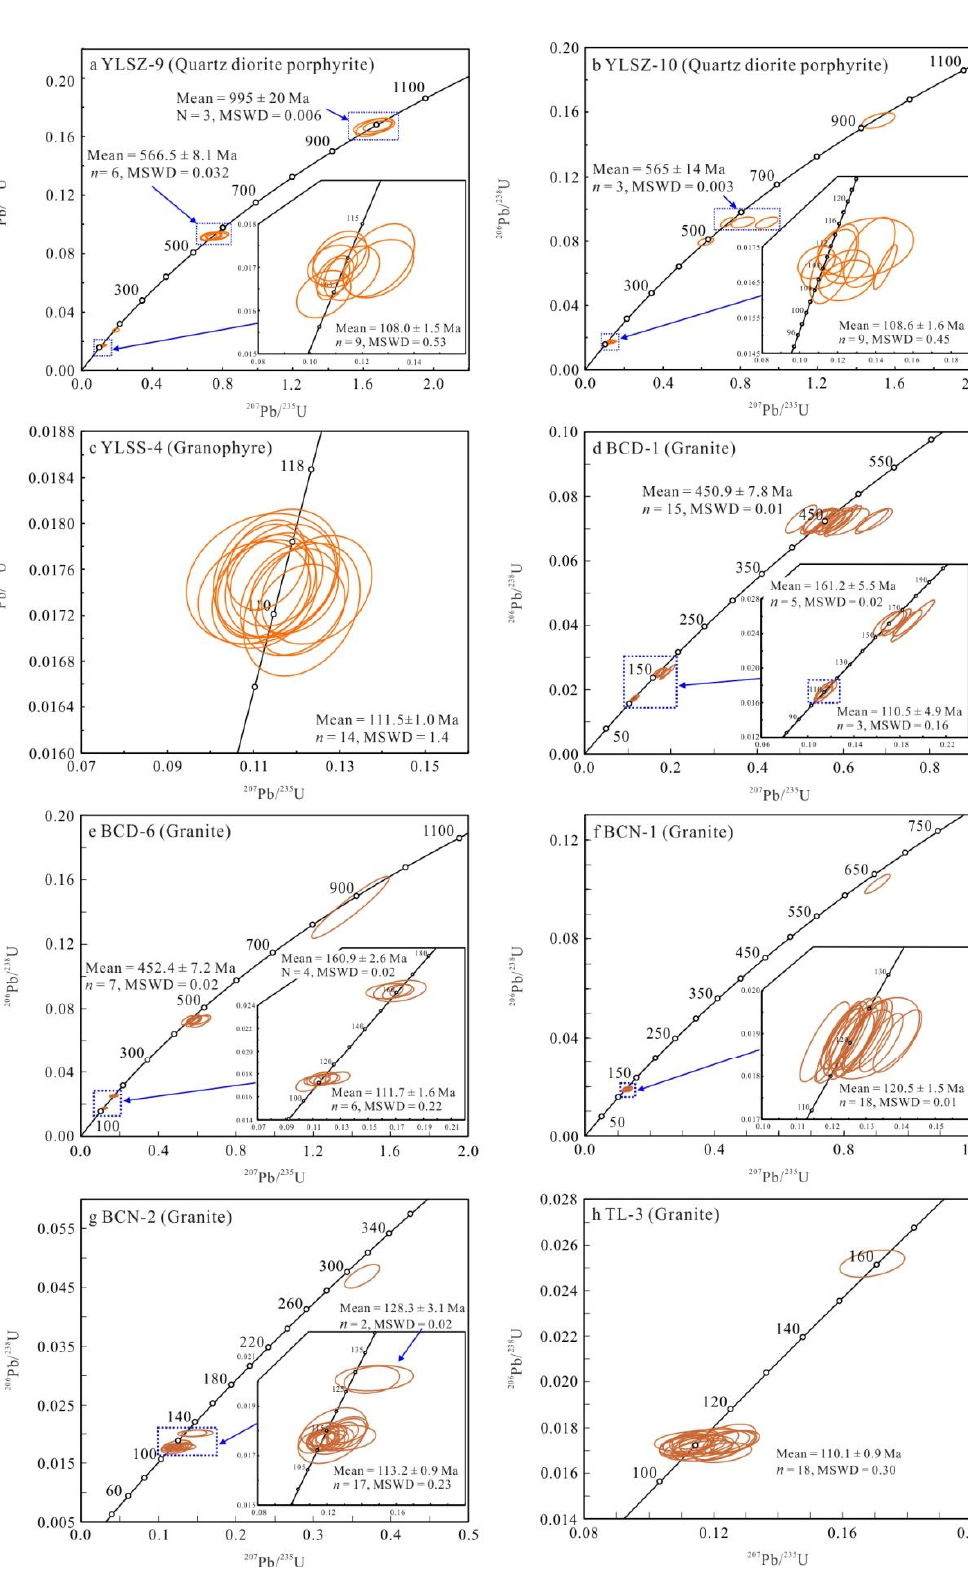
Figure 4. Zircon LA–ICP–MS U–Pb concordia (left) and probability density function (right) diagrams of the analyzed zircons from the Yilashan and Amdo granitoids in the Nagqu area. ( a ): YLSZ–9; ( b ): YLSZ–10; ( c ): YLSS–4; ( d ): BCD–1; ( e ): BCD–6; ( f ): BCN–1; ( g ): BCN–2; ( h ): TL–3.